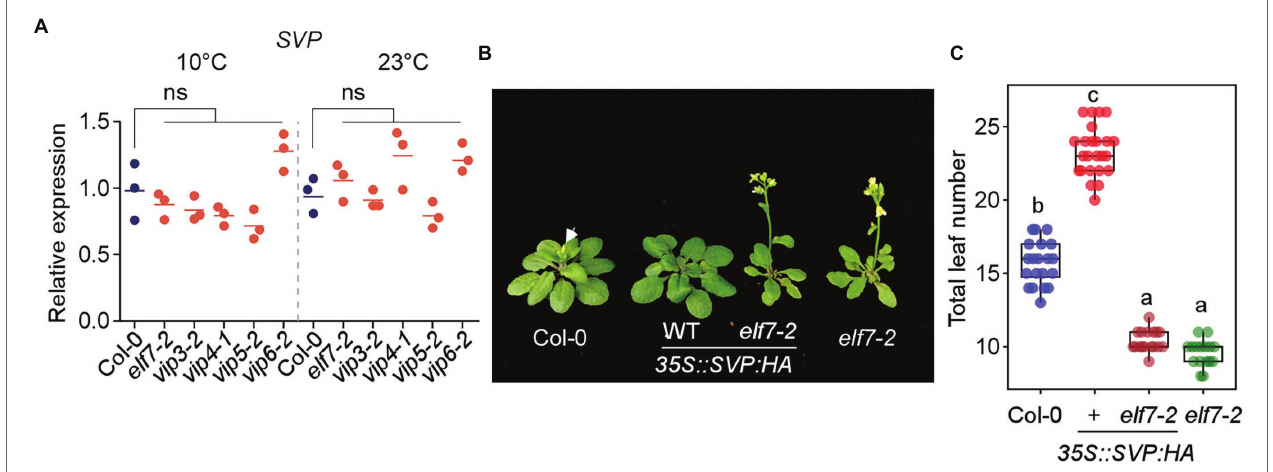
FIGURE 9 | SVP-mediated floral repression is dependent on FLC and FLC -clade genes. (A) SVP mRNA levels in PAF1C-deficient mutants at 10 and 23 ° C under LD conditions. ns; not significant. (B,C) Phenotype (B) and total leaf number (C) of 35S::SVP-HA and 35S::SVP-HA elf7 plants. Note that these plants were first grown on medium containing phosphinothricin for 6 days at 23 ° C, transferred to soil, and then grown at 16 ° C. Letters indicate significant differences by one-way ANOVA followed by Tukey’s range tests ( p <